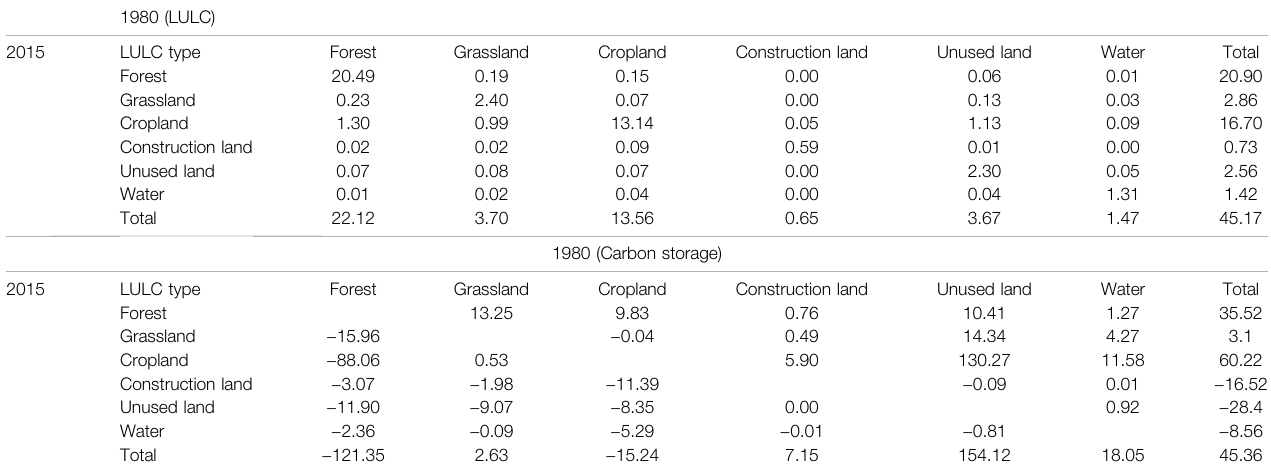
TABLE 2 | LULC and carbon storage transfer matrix during 1980 – 2015 in Heilongjiang Province, Northeast China (10 4 km 2 , 10 6 Mg). 1980 (LULC)